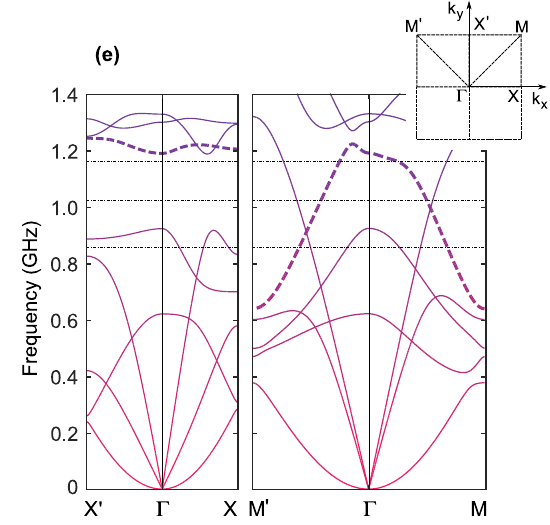
Fig. 1 | Negative asymmetric refraction at the interface between an unpat- terned/patterned metamaterial slab. a Schematic of the effect. b In the realized devices,themetamaterialismadeofL-shape holesarranged inasquarelatticeand etched in a GaAs layer. c , d Qualitative sketch of the isofrequency contours determining the mechanical wave group velocity in the metamaterial region and